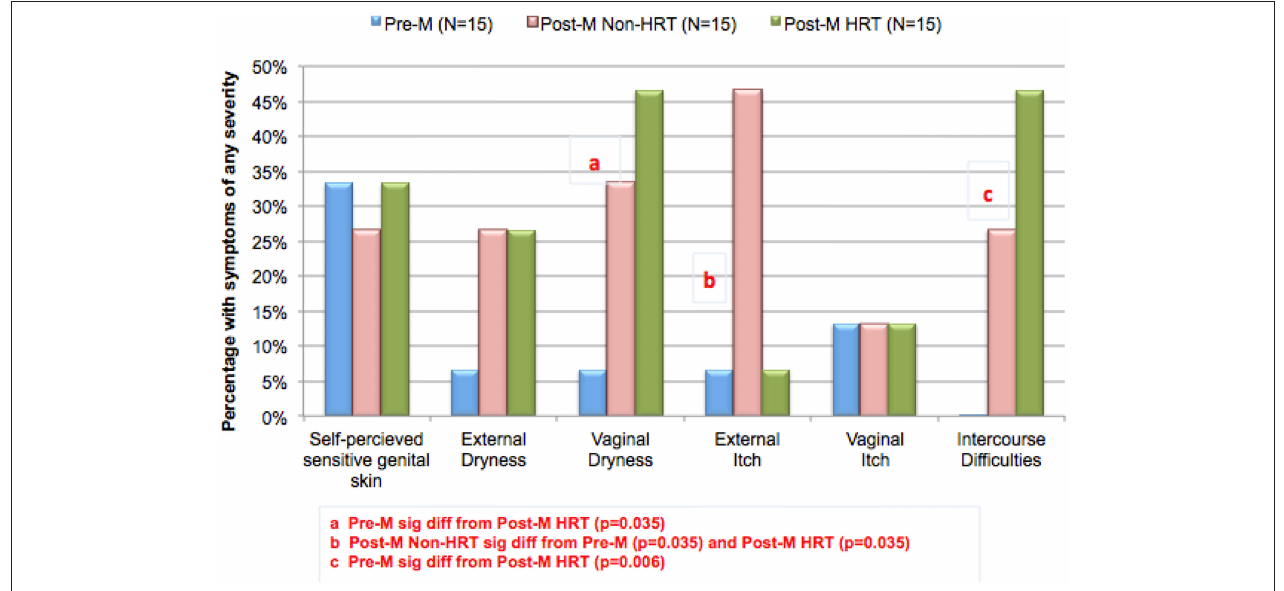
FIGURE 6 | Changing perceptions after menopause. A study was conducted to evaluate potential differences in biomolecular and physical measures of the urogenital skin among women in different stages of life. Participants were asked about perceptions of sensitive genital skin, and about specific subjective symptoms (i.e., external and vaginal dryness, external and vaginal itch, or difficulties with intercourse). The groups (15 each) consisted of women who were: pre-menopausal (Pre-M), post-menopausal on no hormone replacement therapy (Post-M Non-HRT), and post-menopausal receiving hormone replacement therapy (Post-M HRT). The proportion of individuals in each test group claiming any degree of sensitive genital skin or any of the subjective symptoms is plotted. Pairwise comparisons were conducted using Fisher’s exact test.